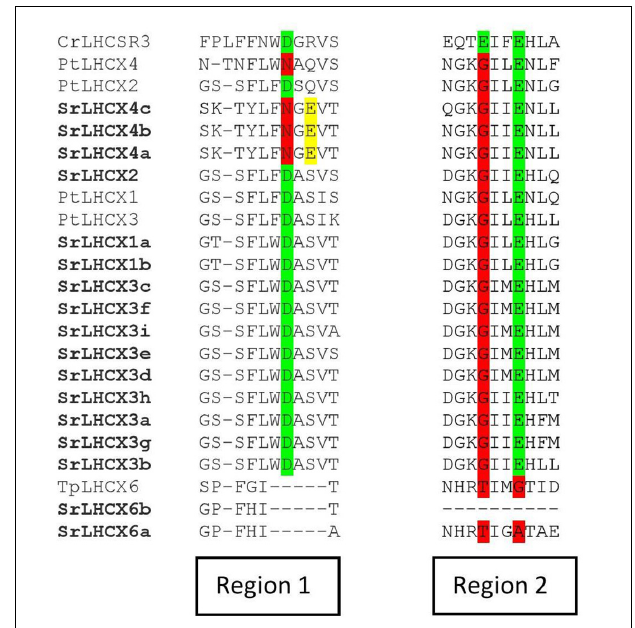
FIGURE 4 | Amino-acid alignment of regions 1 and 2 of Chlamydomonas reinhardtii CrLHCSR3, P. tricornutum LHCX1-4, T. pseudonana LHCX6, and all LHCX sequences of S. robusta . The highlights in green represent conserved pH-sensing residues, whereas red highlights represent the absence of a conserved pH-sensing residue. Glutamate residues (E) in SrLHCX4a-c are highlighted in